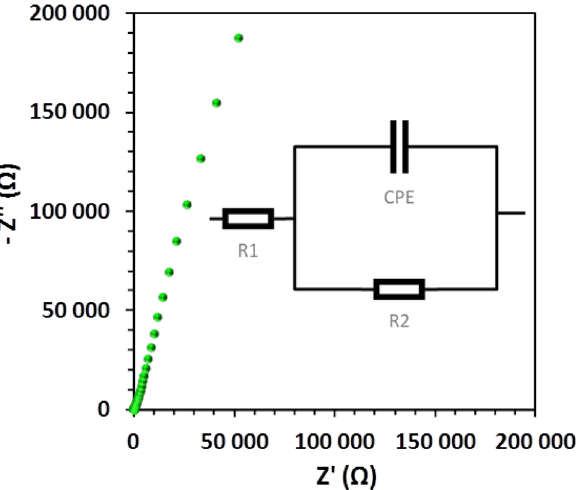
Figure 6. AC impedance spectra for chitin–EG hydrogel, with diagram of the fitting circuit.